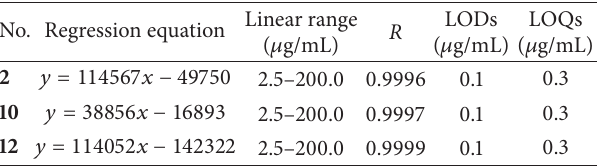
Table 3: Calibration parameters of HPLC analysis for the 3 com- pounds. The structures of marker peaks of 2 , 10 , and 12 can be seen in Figure